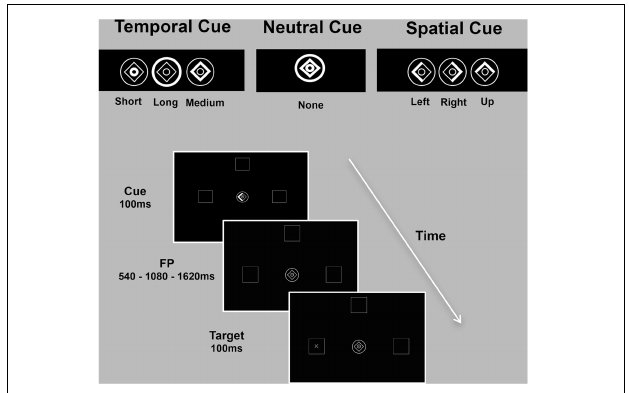
FIGURE 1 | Spatio-temporal predictive task. Participants detected, as quickly as possible, visual targets (‘+’ or an ‘ × ’) appearing at one of three locations (left/up/right) after one of three intervals (short/medium/long). Expectations about stimulus location (spatial condition) or onset (temporal condition) were conveyed by symbolic cues with 80% validity. The cue consisted of a central image (1 ◦ eccentricity) composed of a diamond and two rings. Part of the cue briefly brightened (100 ms) to inform participants on the possible spatial location or temporal onset of the upcoming target. During the spatial condition, the left, up or right side of the diamond was highlighted to inform subjects that the target was likely to appear in the left, up or right peripheral box. In the temporal condition, brightening of the inner circle, diamond or the outer circle indicated that the target would occur after a short (540 ms), medium (1080 ms) or long (1620 ms) delay, respectively. During the neutral condition, no spatial or temporal information was provided. The inter-trial interval (ITI) varied randomly from 600 to 1000 ms. The three experimental conditions (spatial/temporal/neutral) were presented separately in three blocks of trials (90